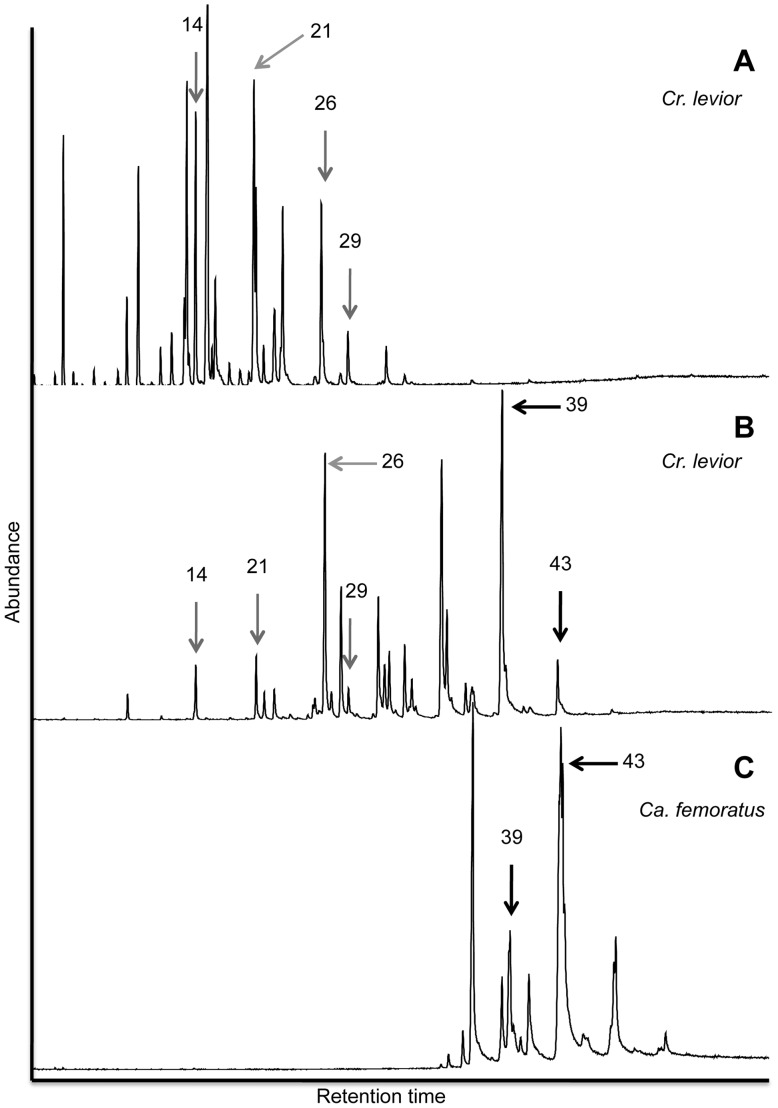
Representative chromatograms of the three chemotypes involved in the parabiotic nests.a) Cr. levior Type A, b) Cr. levior Type B, c) Ca. femoratus. Each peak represents a different hydrocarbon compound, as confirmed by spectral analysis. Compounds shared between species are shown by the arrows, with grey arrows showing peaks shared by only Cr. levior Type A and Cr. levior Type B, and black arrows being compounds shared between Cr. levior Type B and Ca. femoratus. Peak numbers refer to compound numbers in Table 2.